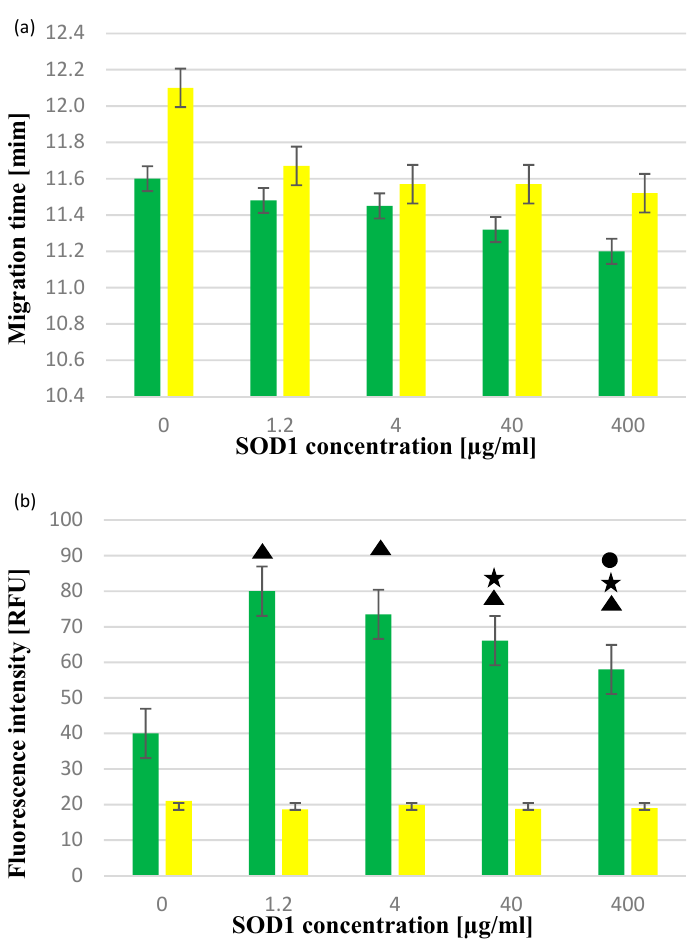
Figure 9. Dependence of ( a ) migration time and ( b ) fluorescence intensity signal on SOD1 concen- tration. The colors in the chart correspond to the colors of QDs. The triangle marks a statistically significant difference compared with the fluorescence of G-QDs alone ( p < 0.05) . The asterisk marks statistically significant differences compared with the fluorescence of complexes in the presence of a 1.2 µ M SOD concentration ( p < 0.05). The circle marks a statistically significant difference compared with the fluorescence of complexes in the presence of a 4 µM SOD concentration ( p < 0.05).